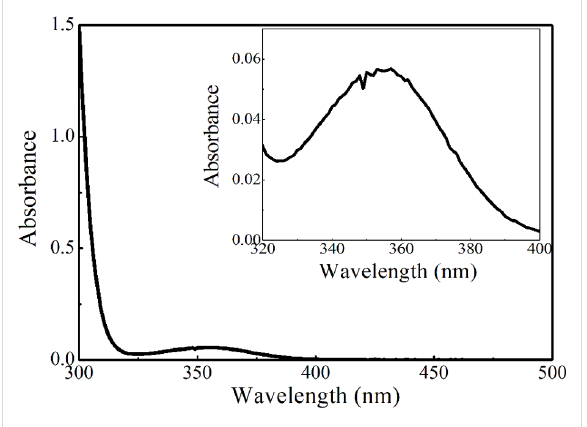
Figure 3: UV–vis absorption spectrum of 1a (1 mM solution in